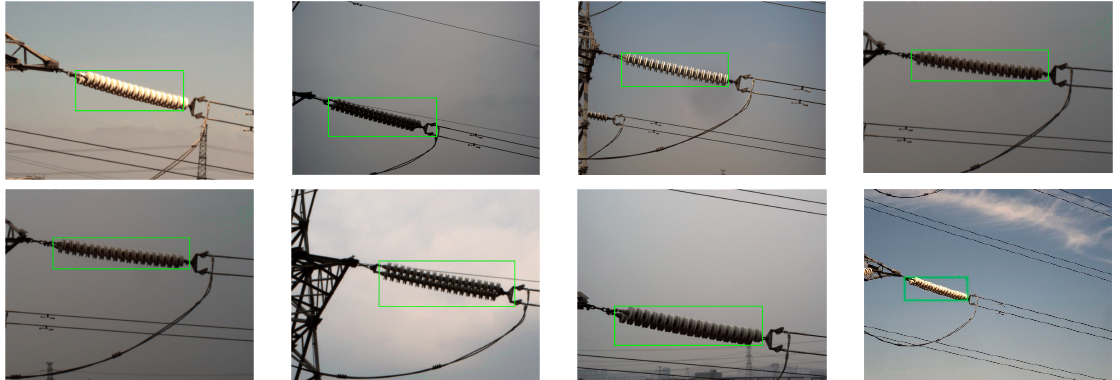
Figure 10. Detection examples of insulators in a simple background.